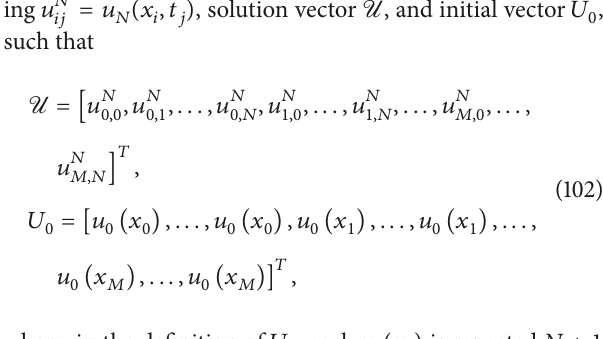
Figure 8: Time-fractional diffusion with 𝛼 = 0.6, 𝛽 = 0.6 .